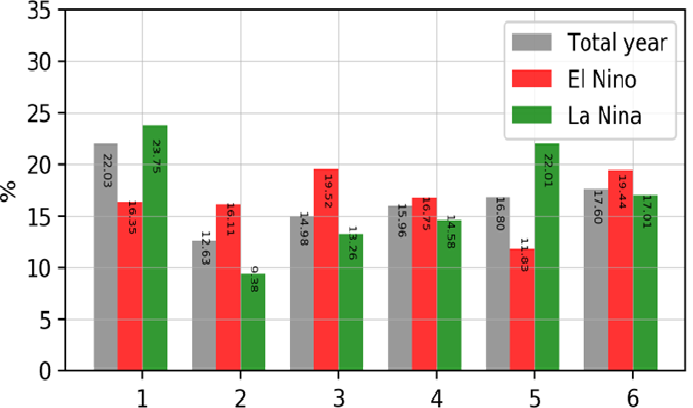
Figure 7. Frequencies of the WTs in all years (grey), El Niño years (red) and La Niña years (green) in December–February of the ENSO